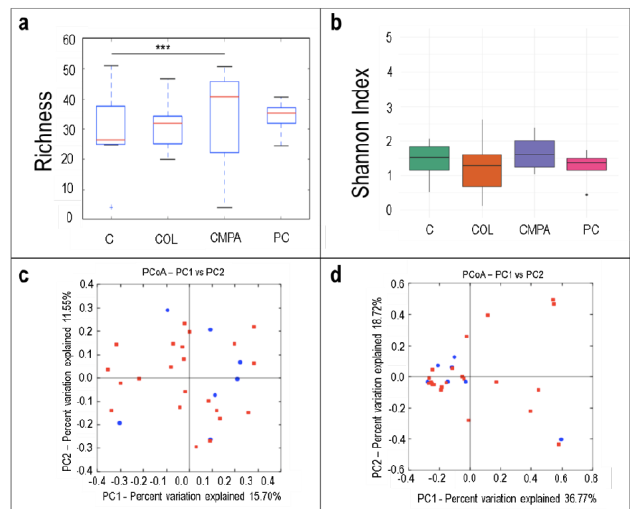
Figure 2. Alpha diversity in the fecal samples ( N = 29) in the different study groups expressed by: ( a ) the number of the observed species (species richness) and ( b ) the Shannon Index. Beta diversity analysis of the study groups measured as: ( c ) the presence/absence (Binnary Jaccard method; p = 0.917) and ( d ) the relative abundance (Bray Curtis method; p = 0.839) of the different species quantified in all disease groups (red) and controls (blue). C, Control group ( n = 7); COL, Colic group ( n = 12); CMPA, Cow’s milk protein allergy group ( n = 5); PC, Proctocolitis group ( n = 5).